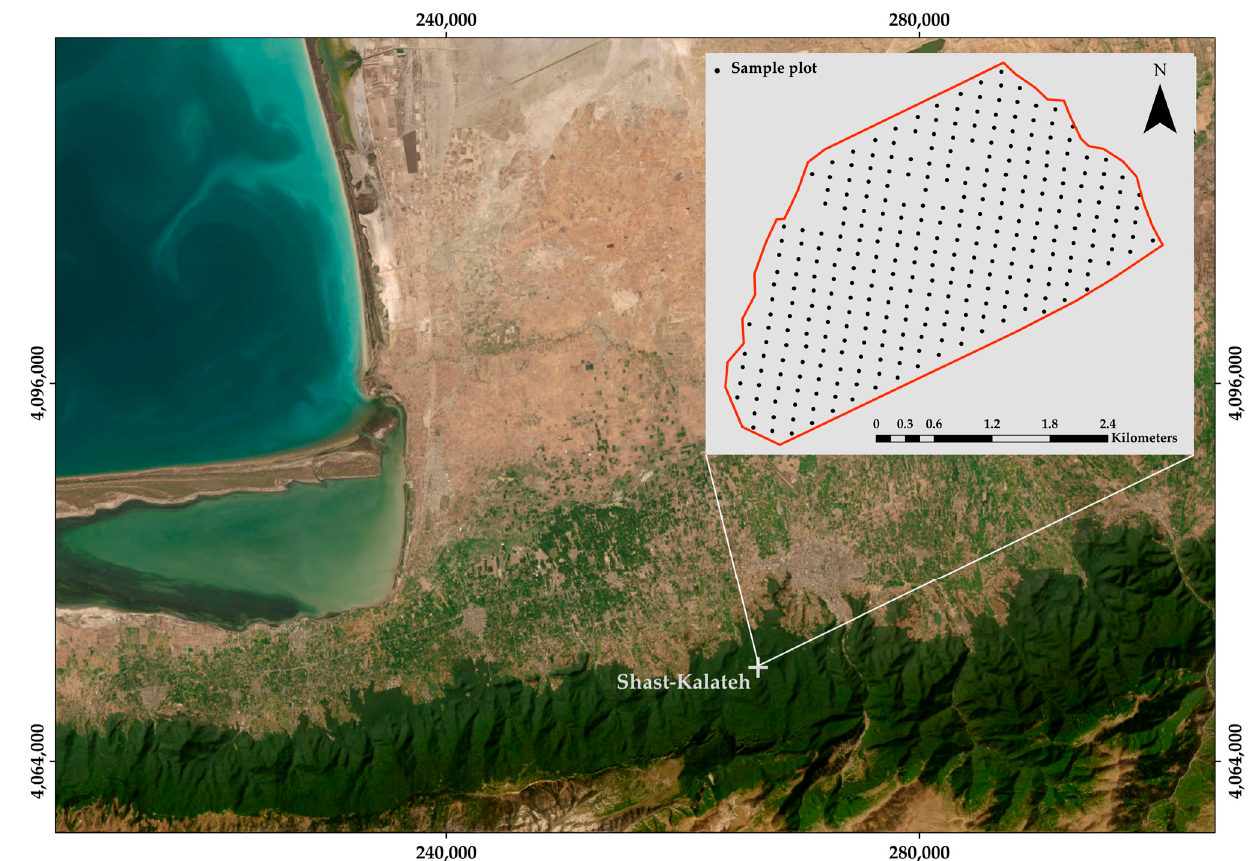
Figure 1. Study area in Shast-Kalateh forest and distribution of 308 circular sample plots. Table 1. Summary statistics of plot-level field